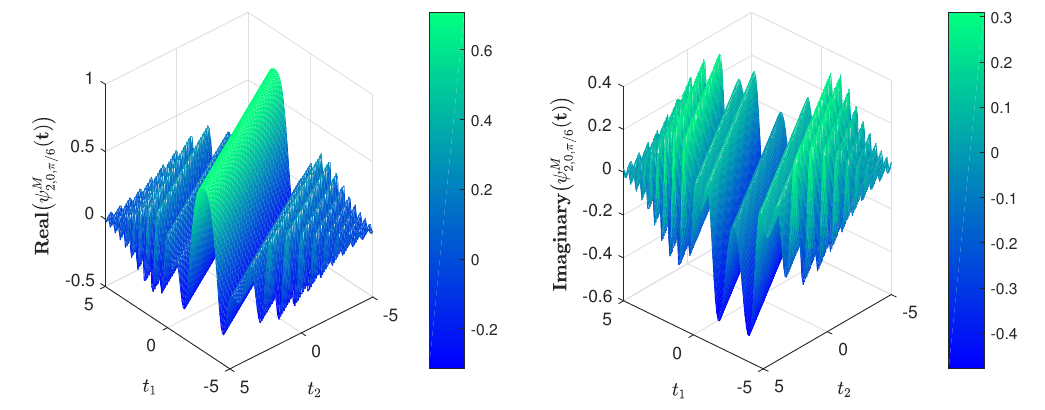
Figure 6. The linear canonical ridgelet waveforms for M = ( 3,1;5,2 ) at scale a = 2, location b = 0, and orientation θ = π